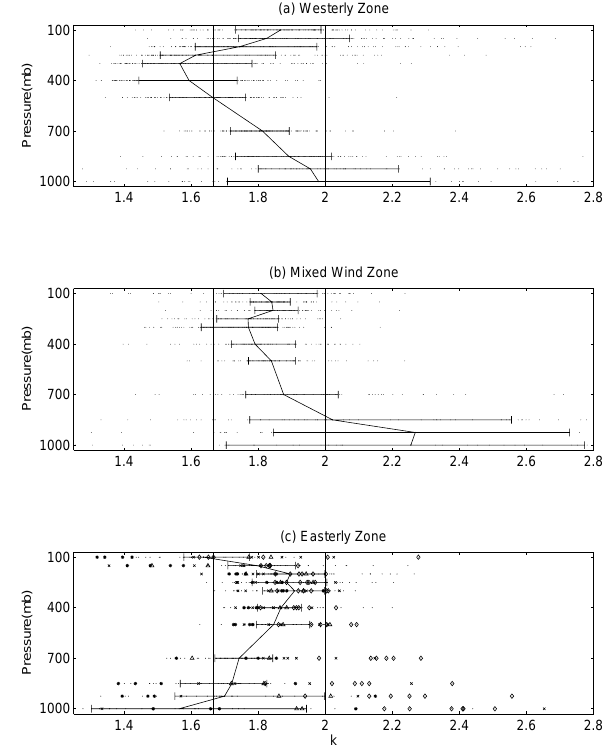
Fig. 8. Scatter plot showing the values of k across vertical levels at tropical stations in the three upper-level climatic wind zones. For each zone: median values at each level are connected to show a ver- tical profile; the delimited horizontal bars denote the inter-quartile range at each level. For the easterly zone, k-values of stations in Africa (“x” sign), South Asia (asterisk), Southeast Asia (dot), In- dian Ocean (triangle) and West Pacific (diamond) are marked with the same symbols as in Fig.